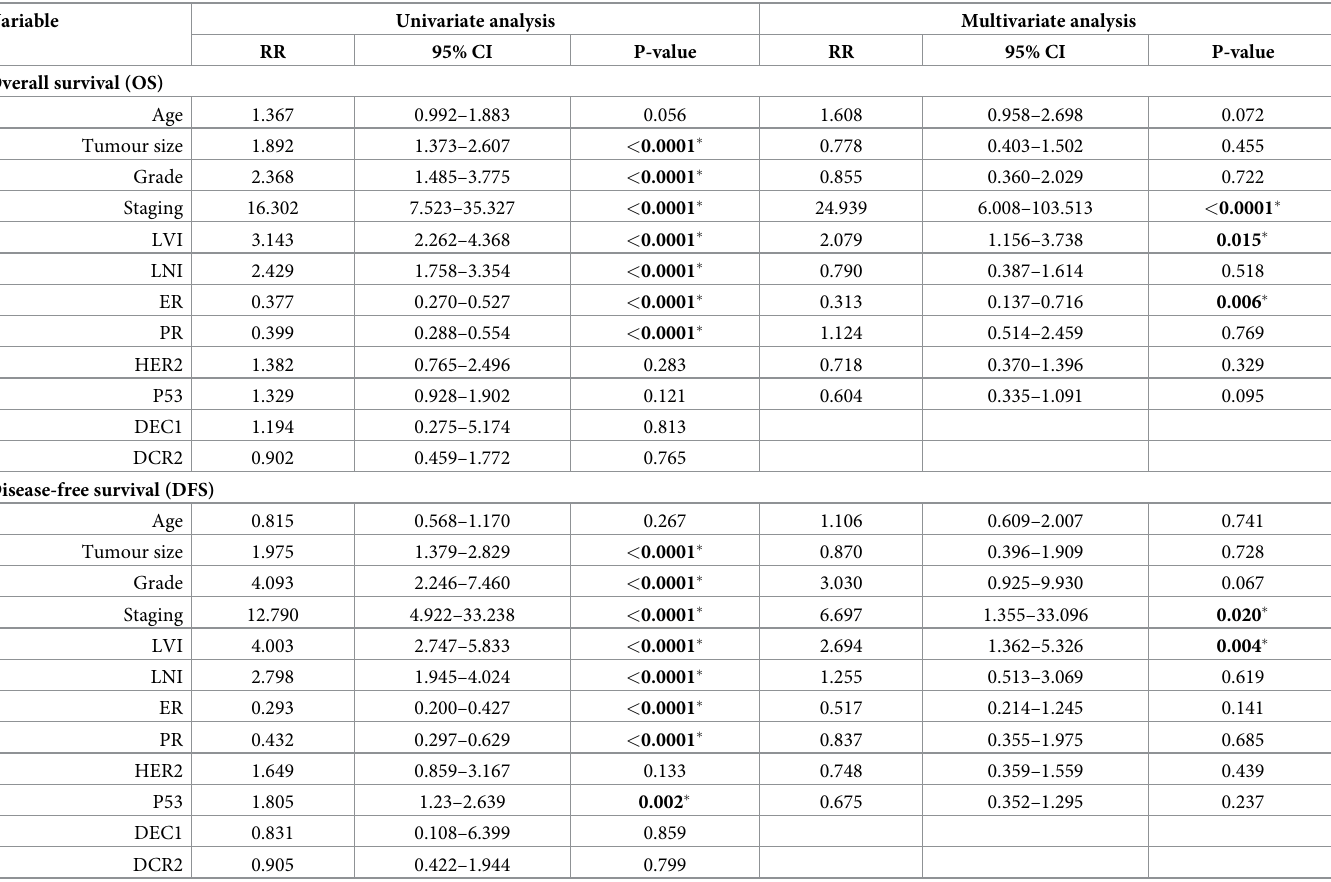
Table 3. Univariate and multivariate cox regression to estimate the hazards